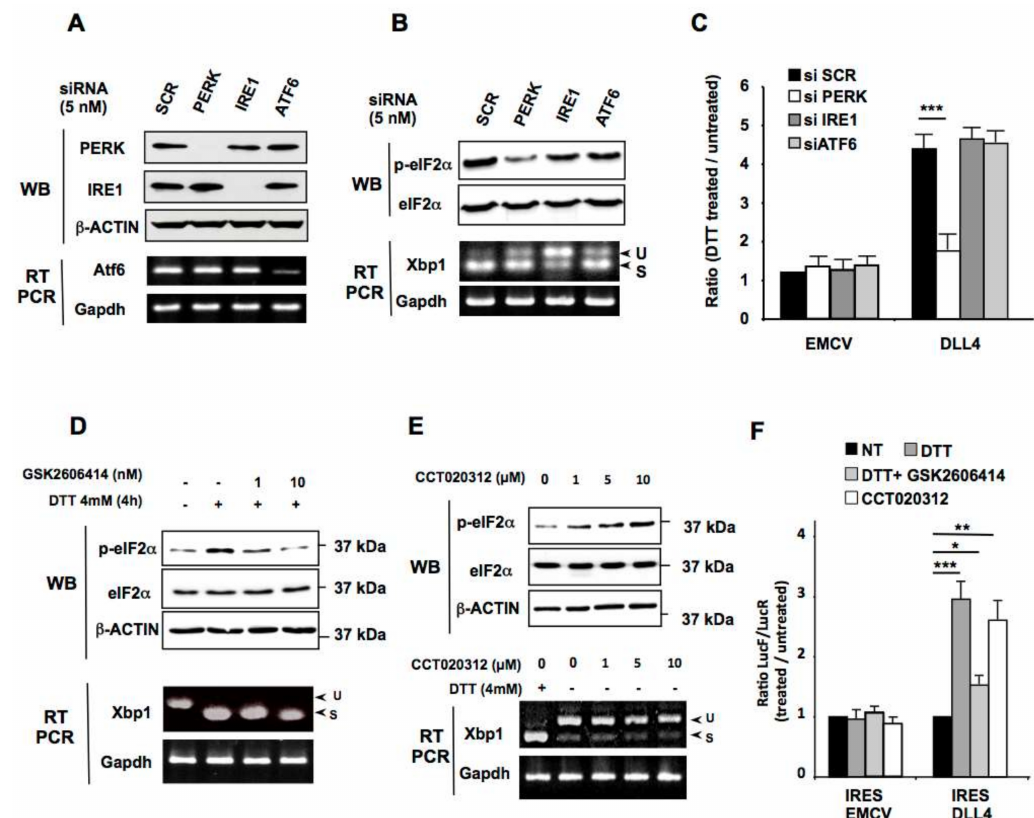
Figure 4. Role of three UPR sensors in DLL4 IRES translation activation by ER Stress. ( A ) HeLa cells were transfected with PERK, ATF6, IRE1 or control (Scr) siRNA. The knockdown efficiency of the targeted transcripts was determined by western blotting with PERK, IRE1 and β -ACTIN antibodies, and by semi-quantitative RT-PCR against ATF6 and GAPDH as a control. ( B ) Western blot analysis of phosphorylated eIF2 α and total eIF2 α and RT-PCR analysis of XBP1 splicing performed after transfection of HeLa cells either with siRNA specific for PERK, ATF6, or IRE1 or with control siRNA (Scr), after treatment with DTT. ( C ) Relative IRES activities in HeLa cells treated with DTT/control after co-transfection with siRNA specific for PERK, ATF6 or IRE1, or with control siRNA (scr) and DLL4 or EMCV bicistronic vectors. ( D ) Western blot analysis of phosphorylated eIF2 α and total eIF2 α and RT-PCR analysis of XBP1 splicing performed after transfection of HeLa cells with DLL4 or EMCV bicistronic vectors, after treatment with DTT and increasing concentration of the PERK inhibitor GSK2606414. ( E ) Western blot analysis of phosphorylated eIF2 α and total eIF2 α and RT-PCR analysis of XBP1 splicing performed after transfection of HeLa cells with DLL4 or EMCV bicistronic vectors, after treatment with increasing concentration of the PERK activator CCT020312. ( F ) Relative IRES activities in HeLa cells treated with DTT/control after transfection with DLL4 or EMCV bicistronic vectors and treatment with PERK activator (CCT020312) or inhibitor (GSK2606414). The results represent the means of three independent experiments ( ± SEM), * p < 0.05, ** p < 0.01, *** p <